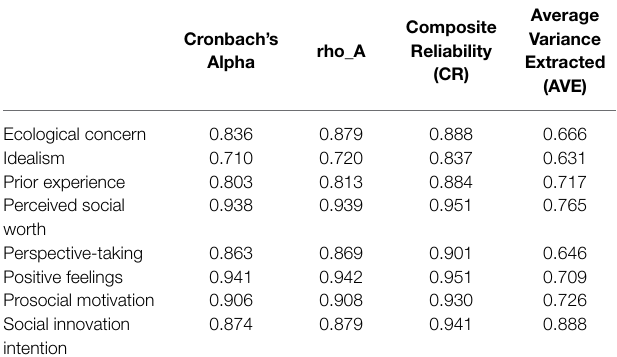
TABLE 2 | Validity and reliability of research